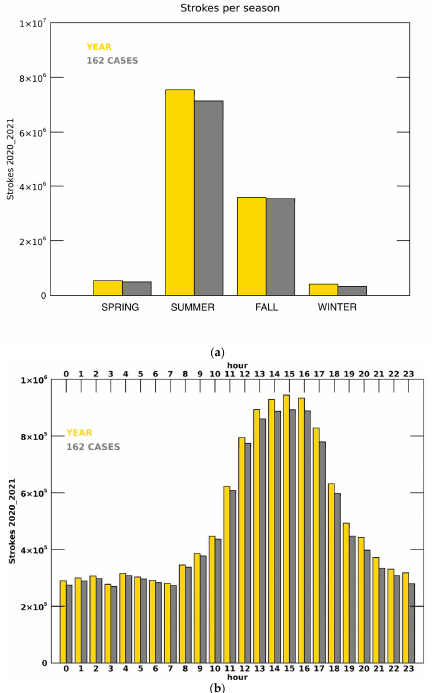
Figure 2. ( a ) Total number of observed strokes in different seasons for all days (yellow) and the 162 cases studied (grey); ( b ) the hourly distribution of the strokes shown in a). In addition to the 486 simulations introduced above, the 46 fall cases were simulated with the WSM6 [89] microphysics scheme to assess the impact of changing the microphysics scheme of WRF on the strokes forecast.